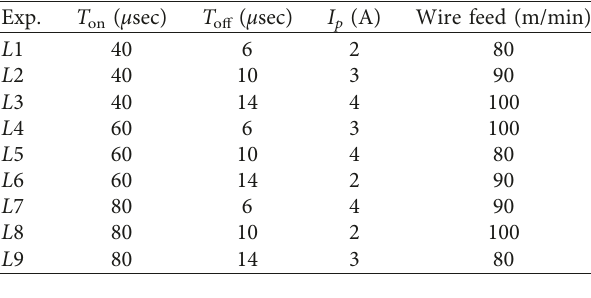
Table 2: Design of experiments.